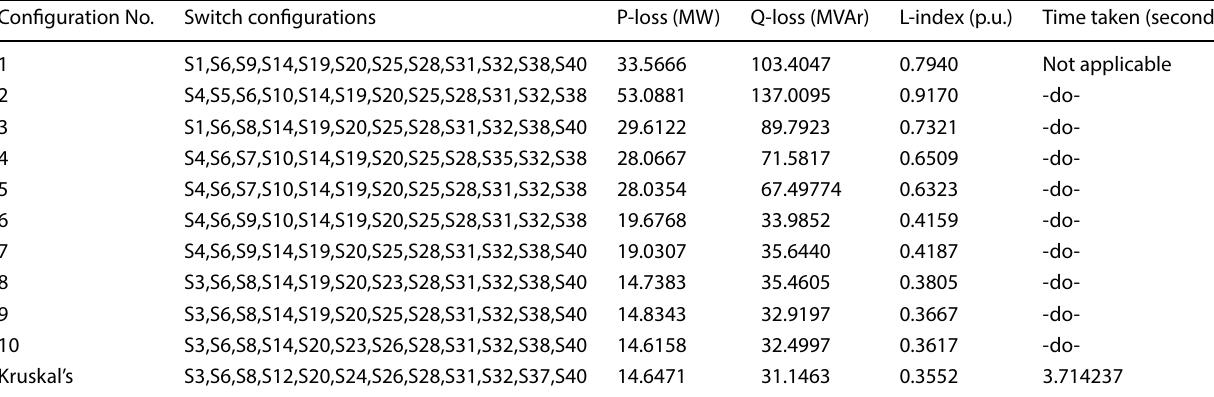
Table 5 Calculated values of L-index, P-loss, and Q-loss at 80% of base load Configuration No.